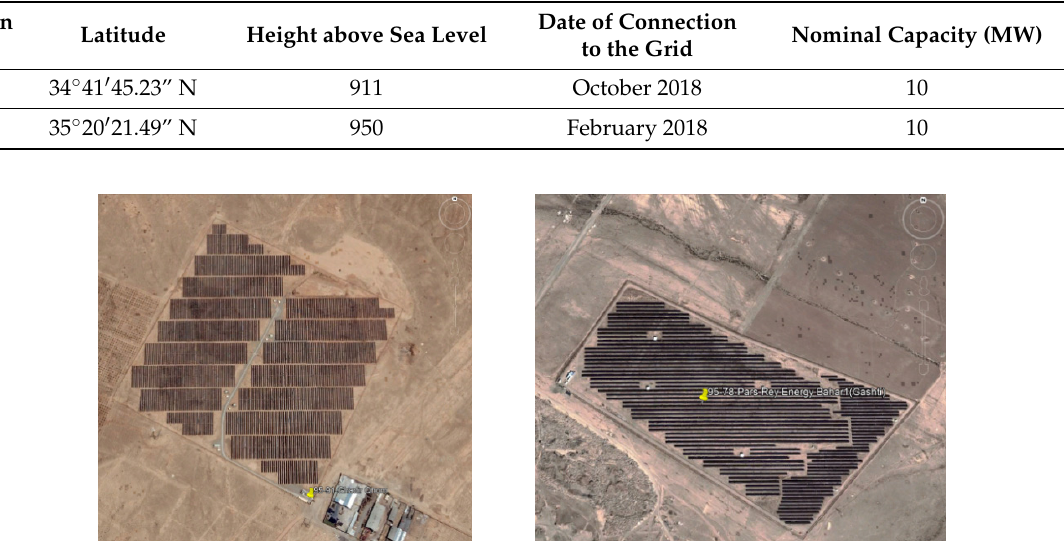
Table 2. Geographical information of two 10 MW power plant near Tehran.